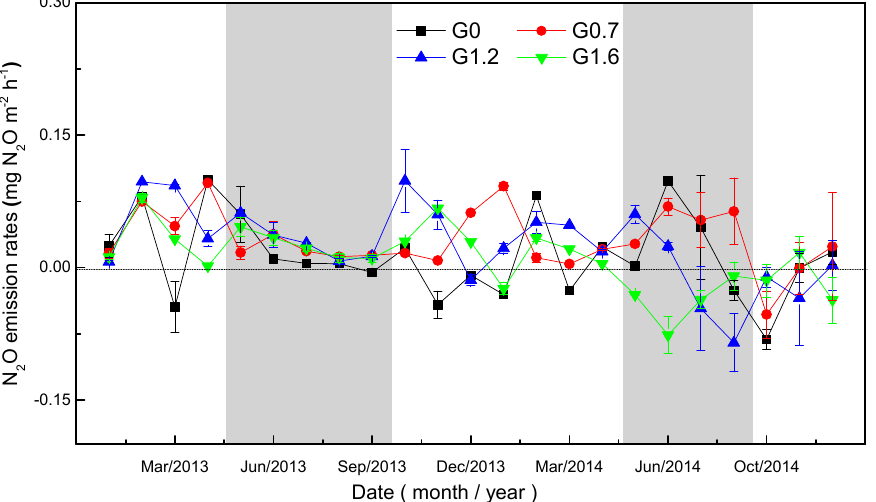
Figure 2. Seasonal pattern of soil N 2 O emissions under different grazing intensities from 2013 to 2014. Bars represent the means of replicate plots ( ±SE).